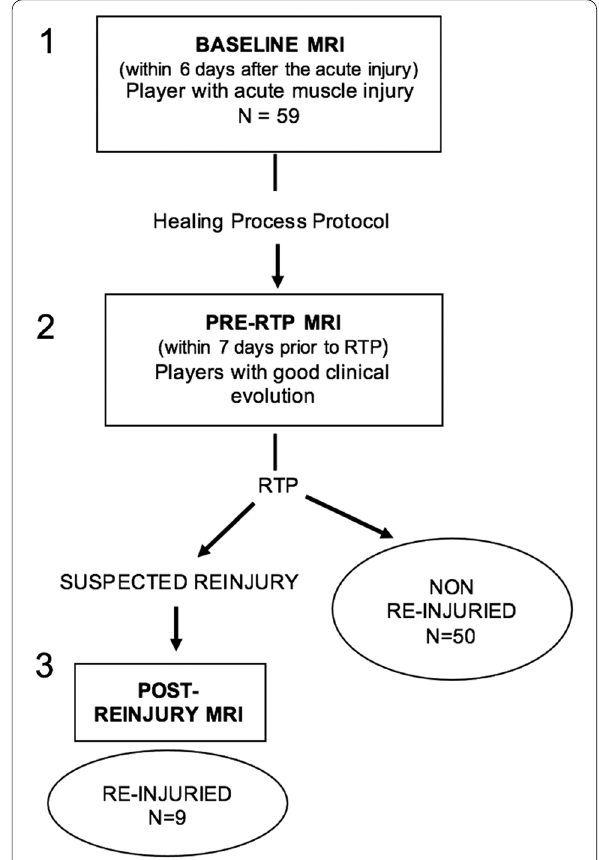
Fig. 2 Flow diagram of patients with muscle injuries of the lower extremities included in the